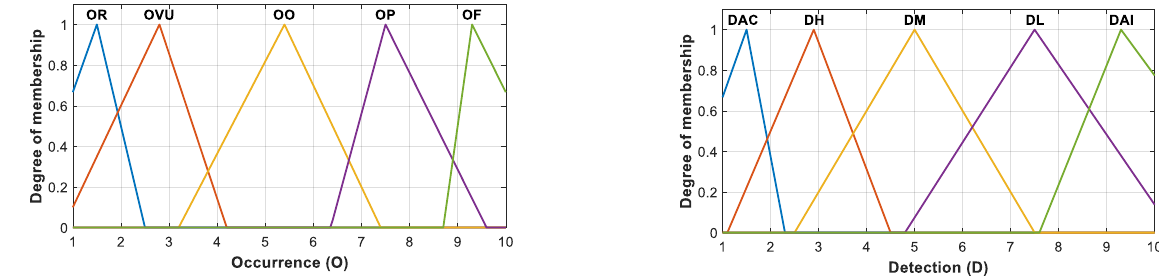
Figure 6. Triangular type-I FIS membership functions for the FMECA risk factors occurrence and detectability.